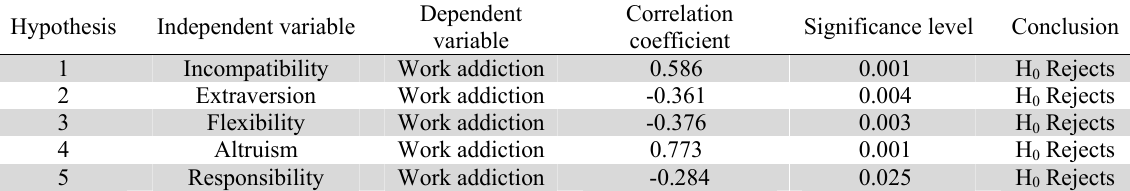
Results of correlation